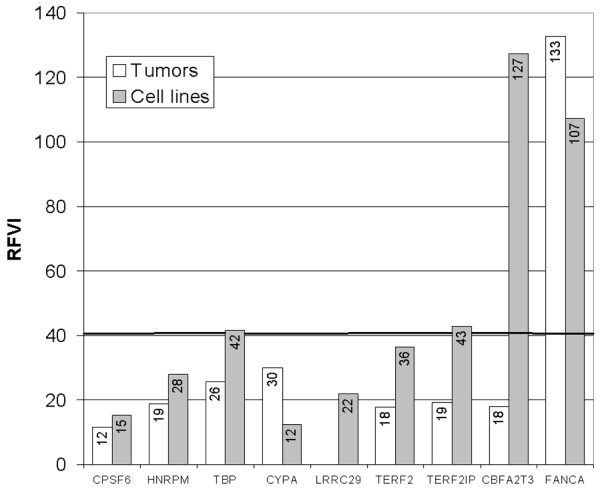
Relative fold variability index (RFVI) of the analysed candidate genes in breast tumours (hatched bars) and breast cancer cell lines (grey bars). Only FANCA and CBFA2T3 in cell lines display levels above the baseline.